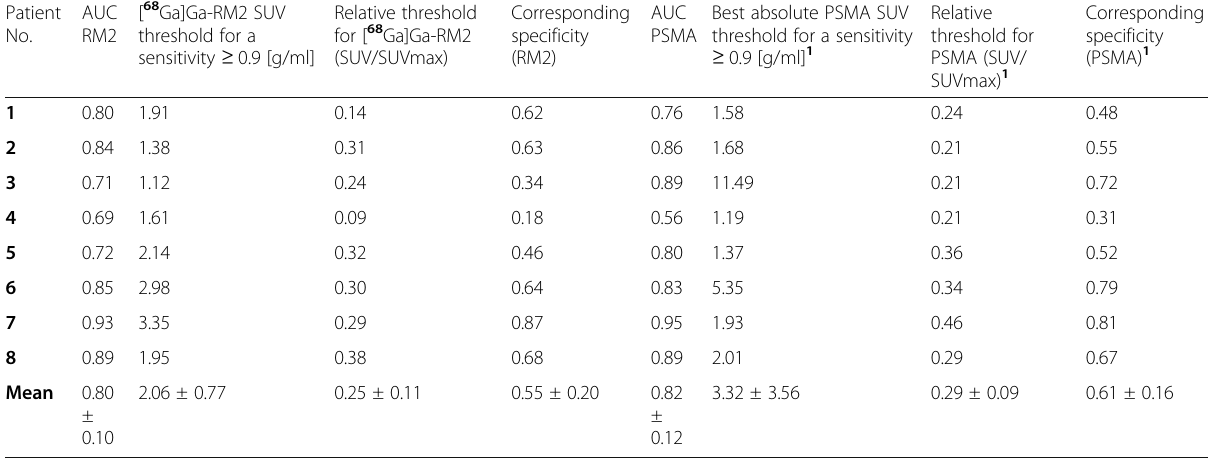
Table 2 Overview of ROC analyses for 68 Ga-RM2-PET and 68 Ga-PSMA-11-PET with binary histoPET as reference Patient